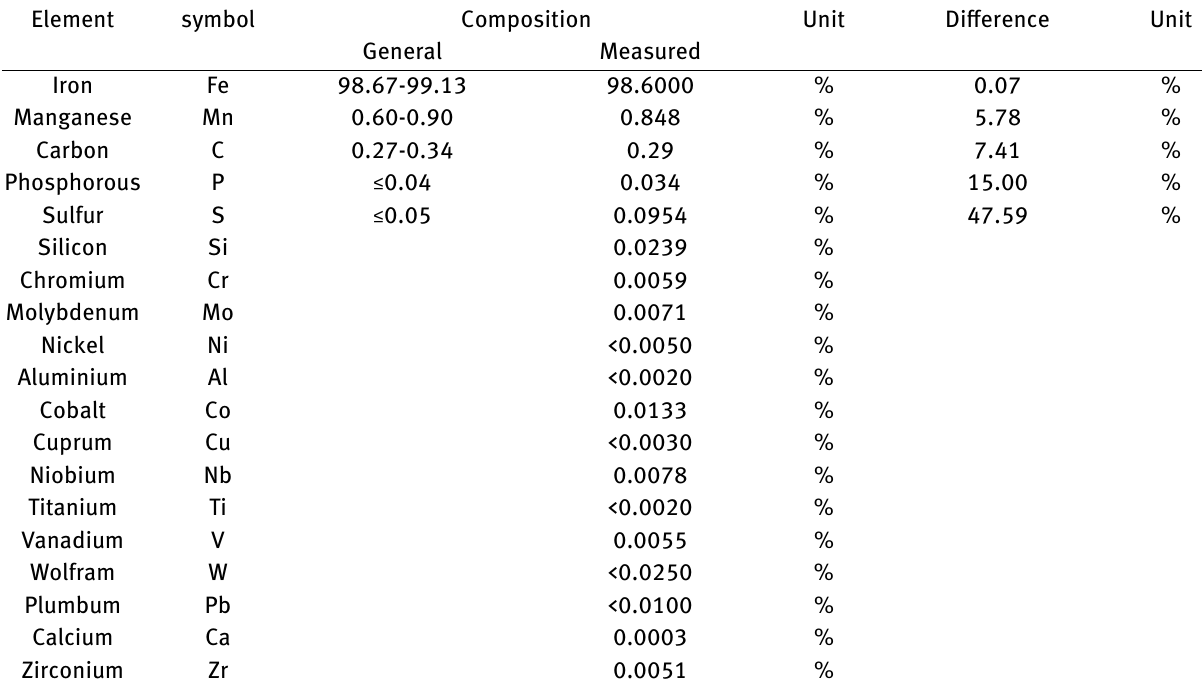
Table 1: Chemical composition experiment results. Element symbol